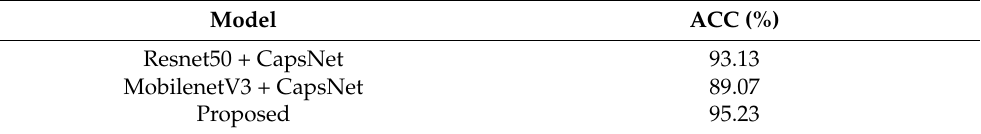
Table 4. Ablation study on MIXFV.